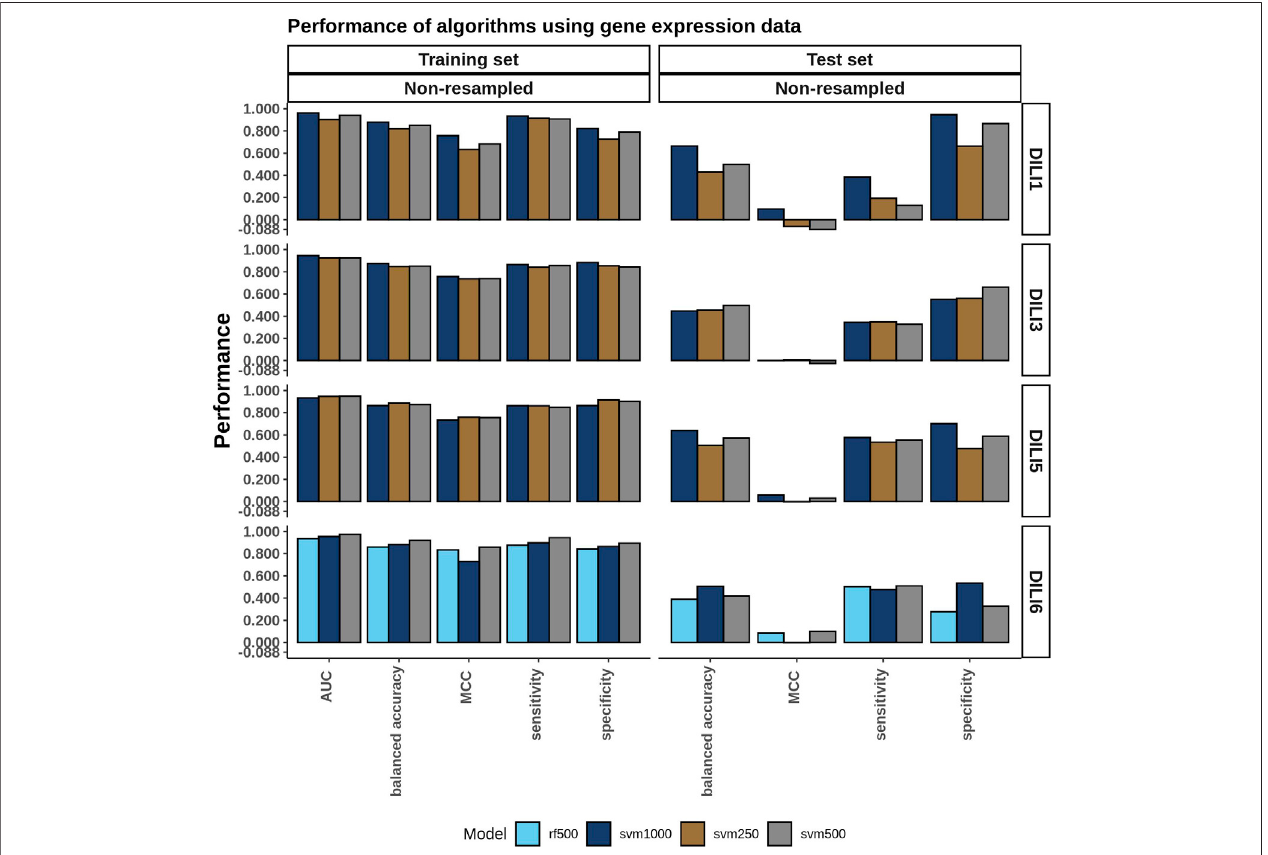
FIGURE6| CellExpressionModelPerformance.AsinglecellexpressionsignatureforeachdrugwasgeneratedusingKru-Bormergingacrossallcelllinesinwhich thedrugwastested asdescribedinthemethods.Followingmerging,featureselectionusinga fi sher ’ sexacttestwasperformedonexpression signaturesofthetopand bottom100,250,500,and1,000rankedgenes.Modelsbuiltonthesepredictorswereevaluatedandthetop-performingones,basedonAUC,areshowninthetraining set bar graph.